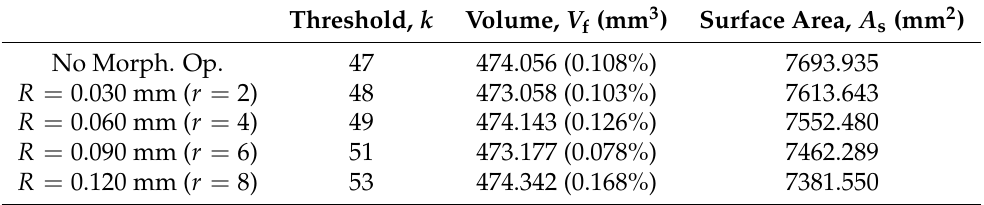
Figure 5. Sensitivity Analysis for different radii of the structuring element. Table 2. Ideal thresholds for the closed-cell foam specimen with different morphological operations. The error (%) in volume with regard to the real foam is also